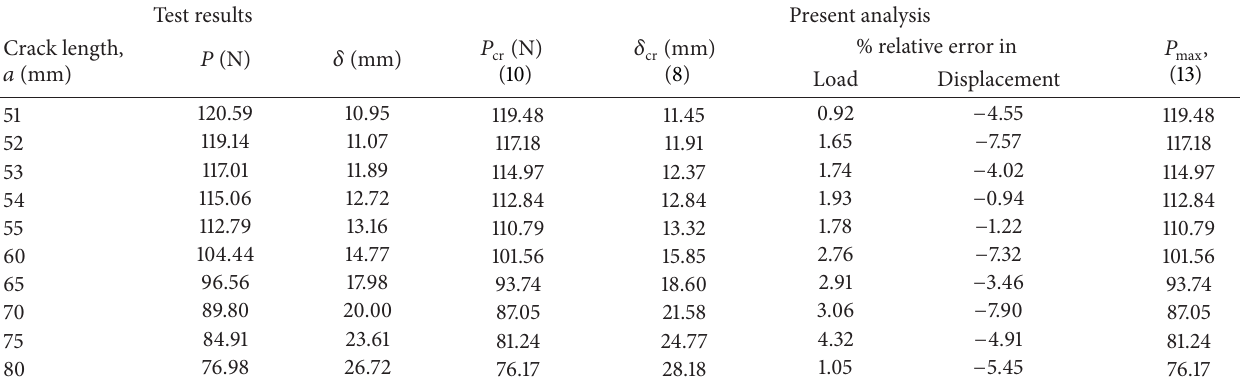
for the measured crack length of a DCB specimen made of unidirectional cr